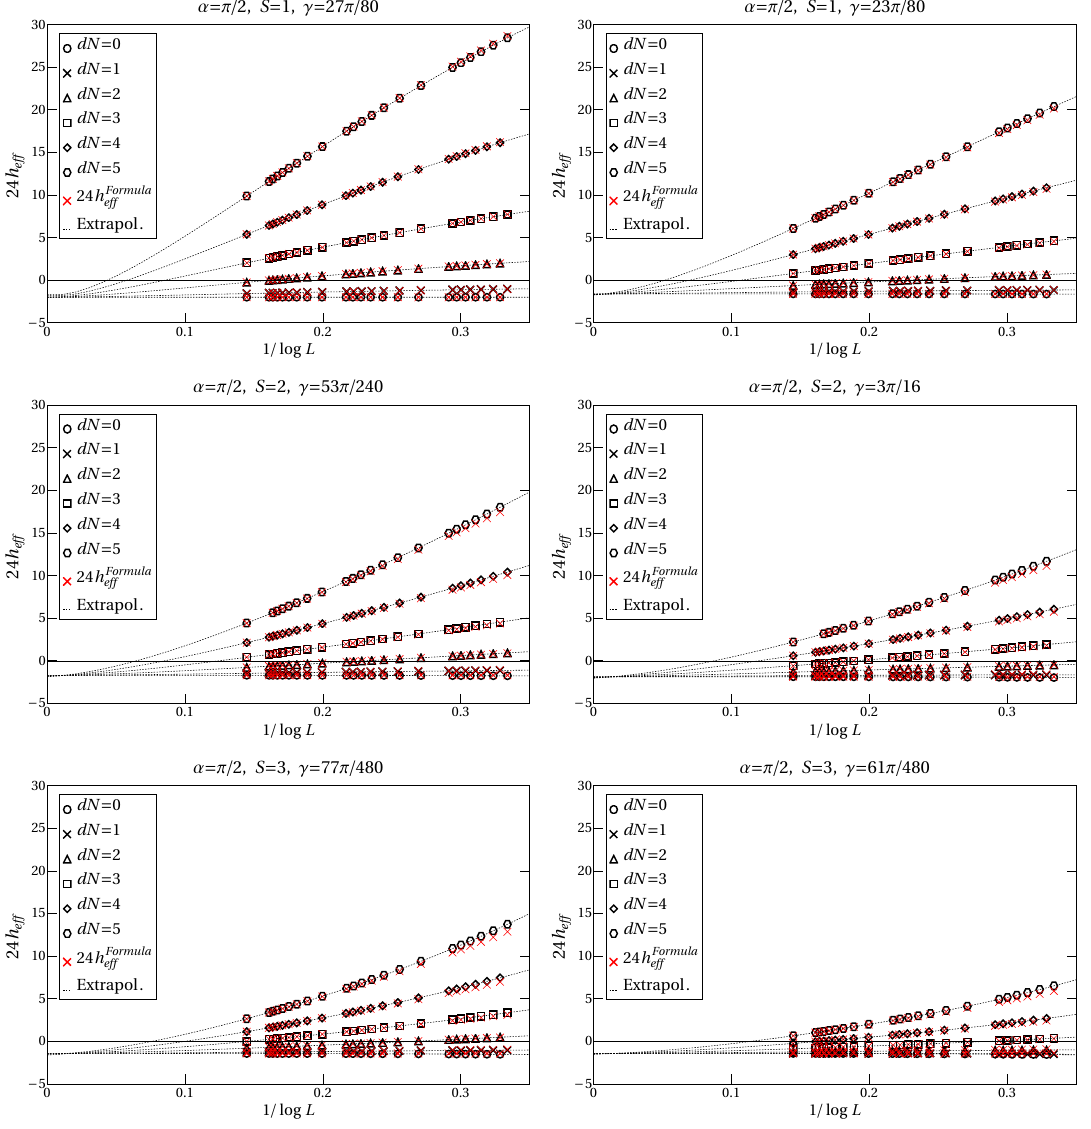
Figure 8 . Spectrum of conformal weights for the self-dual model (i.e. dN GS = 0 ): for each S = 1 , 2 , 3 we have chosen two values of the anisotropy in the intervals (5.8) S is the spin of the ground state. Black symbols are the effective scaling dimensions obtained from eq. (5.19) using the finite size energies obtained from the solution of the Bethe equations. Red symbols represent the scaling dimensions obtained from (6.6) using the Bethe ansatz results for the quasi-momentum s . Note that the latter provide an excellent parameterization of the logarithmic corrections via the continuous variable s for all γ values considered (e.g. in the top-right figure for the parameters used in figure 6b showing the lifting of the degeneracy of (6.5) w.r.t. dN